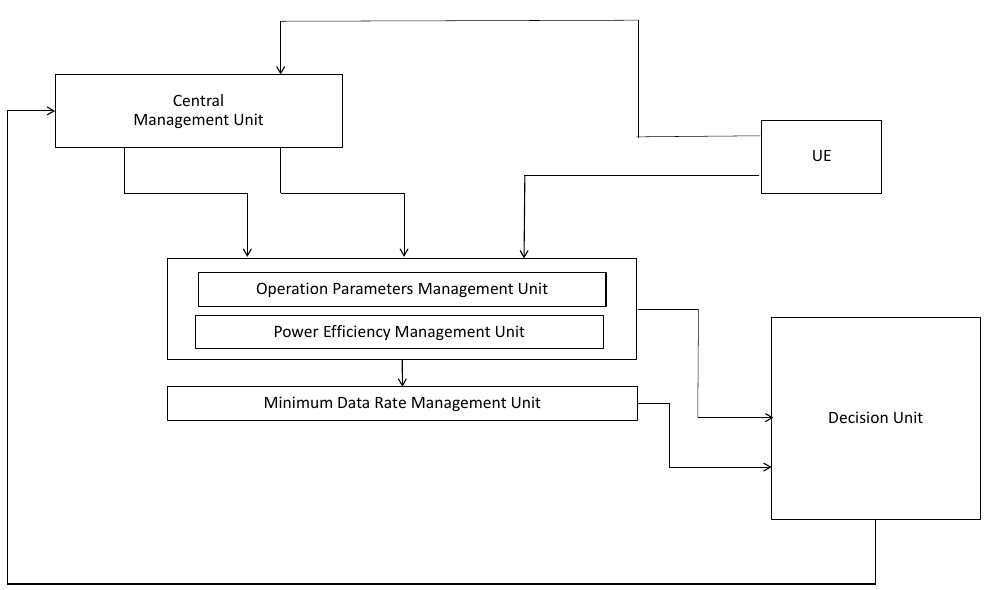
Figure 3. Example of system block diagram for proposed